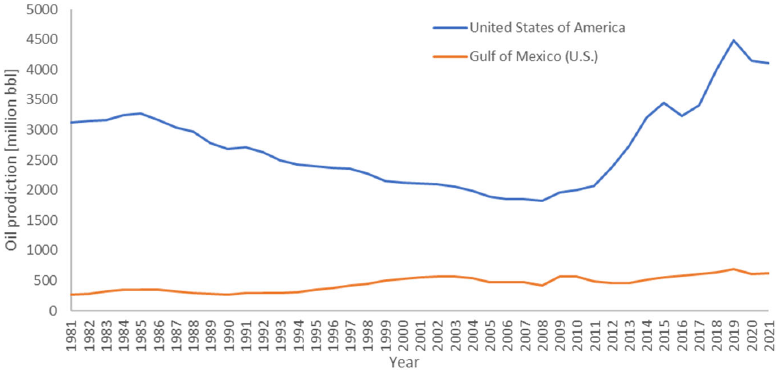
Figure 5. USA and GoM oil production (last 40